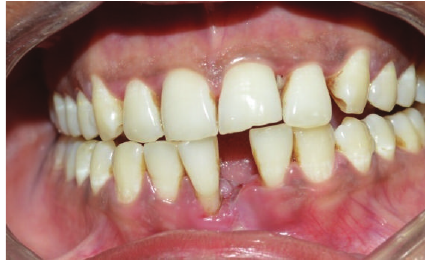
Figure 2: Atraumatic extraction.